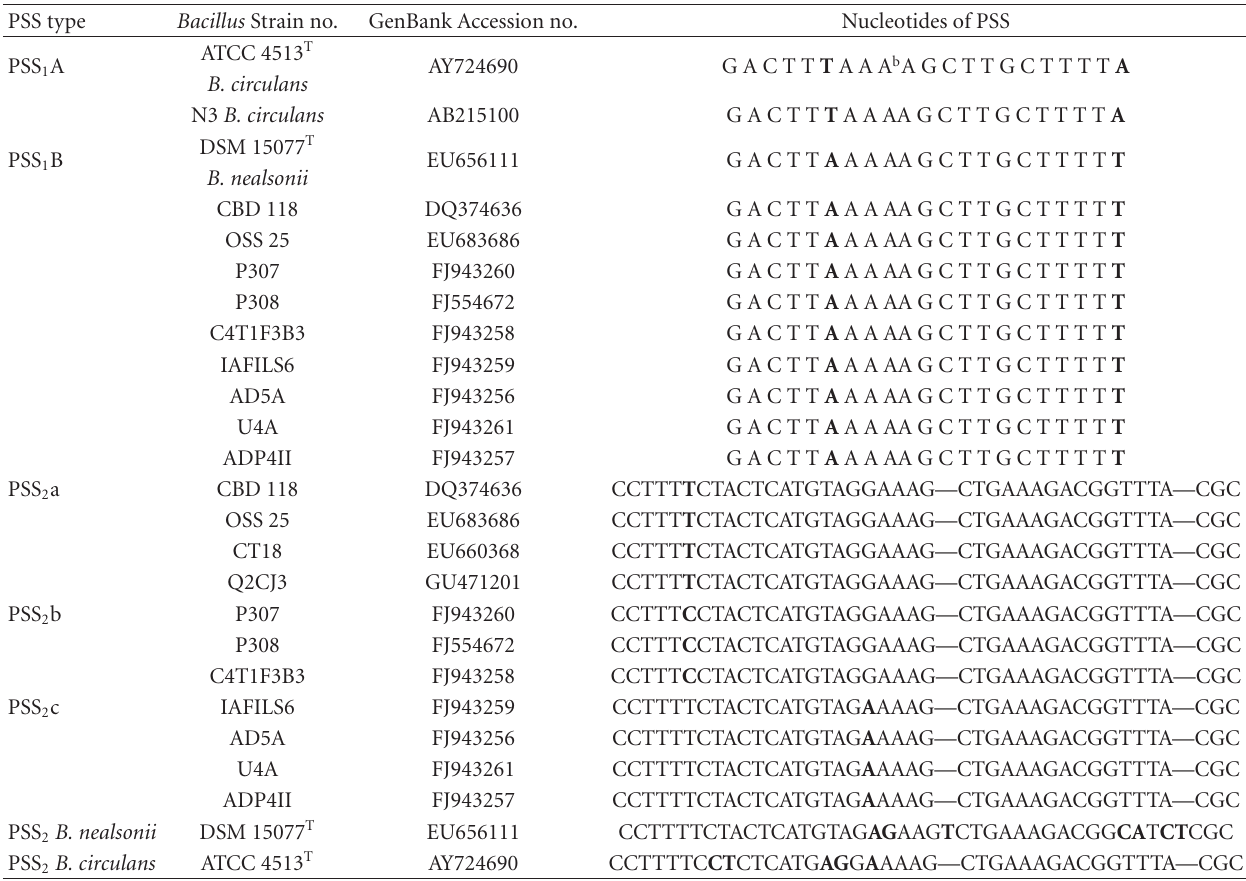
Table 1: Presumptive signature sequences (PSS) conserved in 16S rRNA gene at nt positions 71–92 a,b (PSS 1 ) and 183–223 a (PSS 2 ) in respec- tive V1 and V2 hypervariable regions of Bacillus nealsonii- related strains. a Numbering based on rrn E of Bacillus subtilis subsp subtilis strain 168 T (NC 000964.3); b gap at nt position 80 in PSS 1 sequence alignments to rrn E is reflected in the